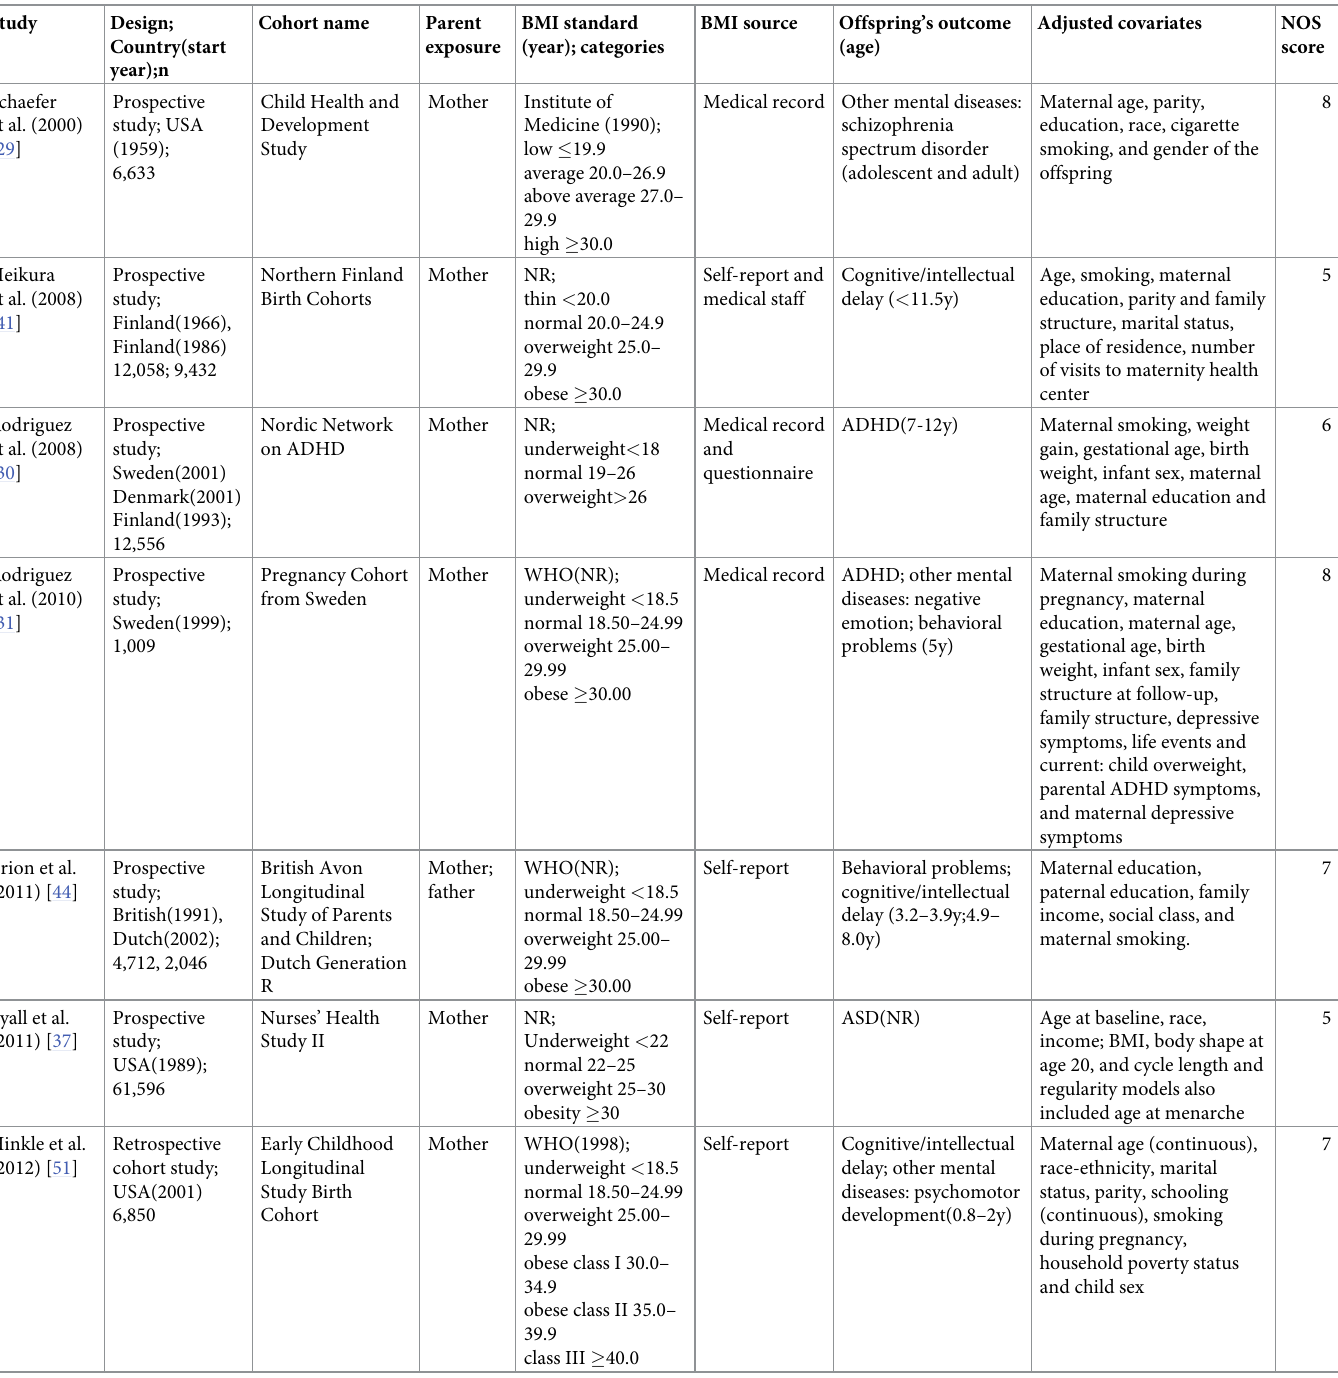
Table 2. Characteristics of the included 35